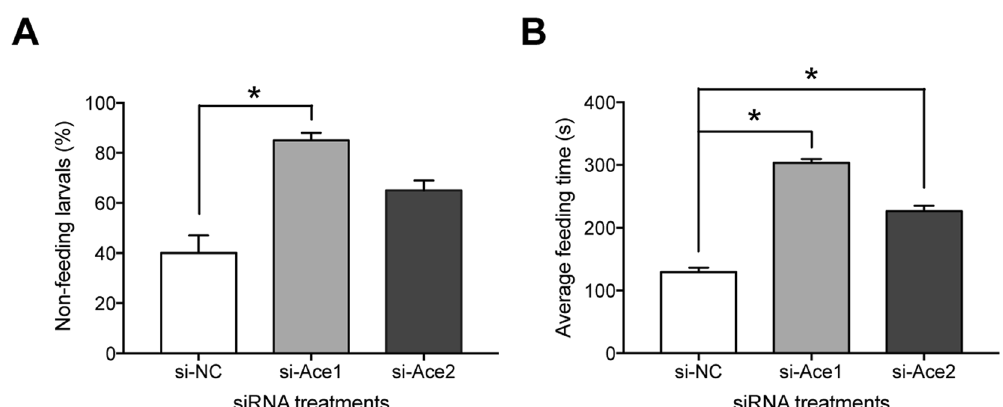
Figure 4. siRNA treatments led to reduced motor activity at 120 h PI. Panel A: Percent of larvae not able to move to the mulberry leaves after 20 mins. The histogram bars indicate percent of treated larvae that were unable to move to the leaves. The error bars indicate 1 SEM. * Significant difference at P ≤ 0.05. Panel B: The mean time (s) required to move to the mulberry leaves. The histogram bars indicate mean times and the error bars indicate 1 SEM. The asterisks indicate significant differences. All experiments were repeated in triplicate, n =